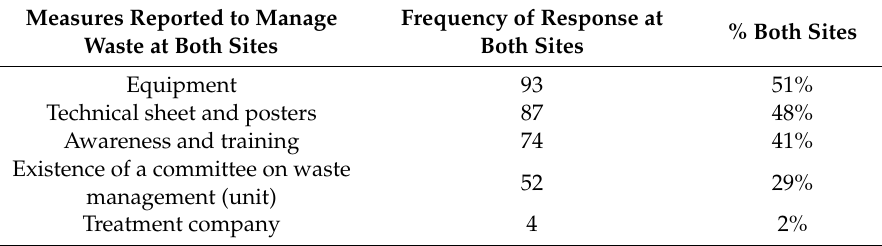
Table 4. Strategies utilized for waste management.